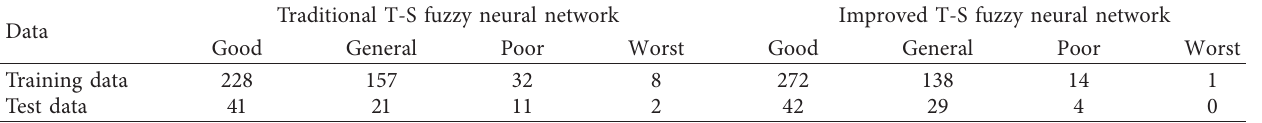
Table 3: Acceptability of predicted values.